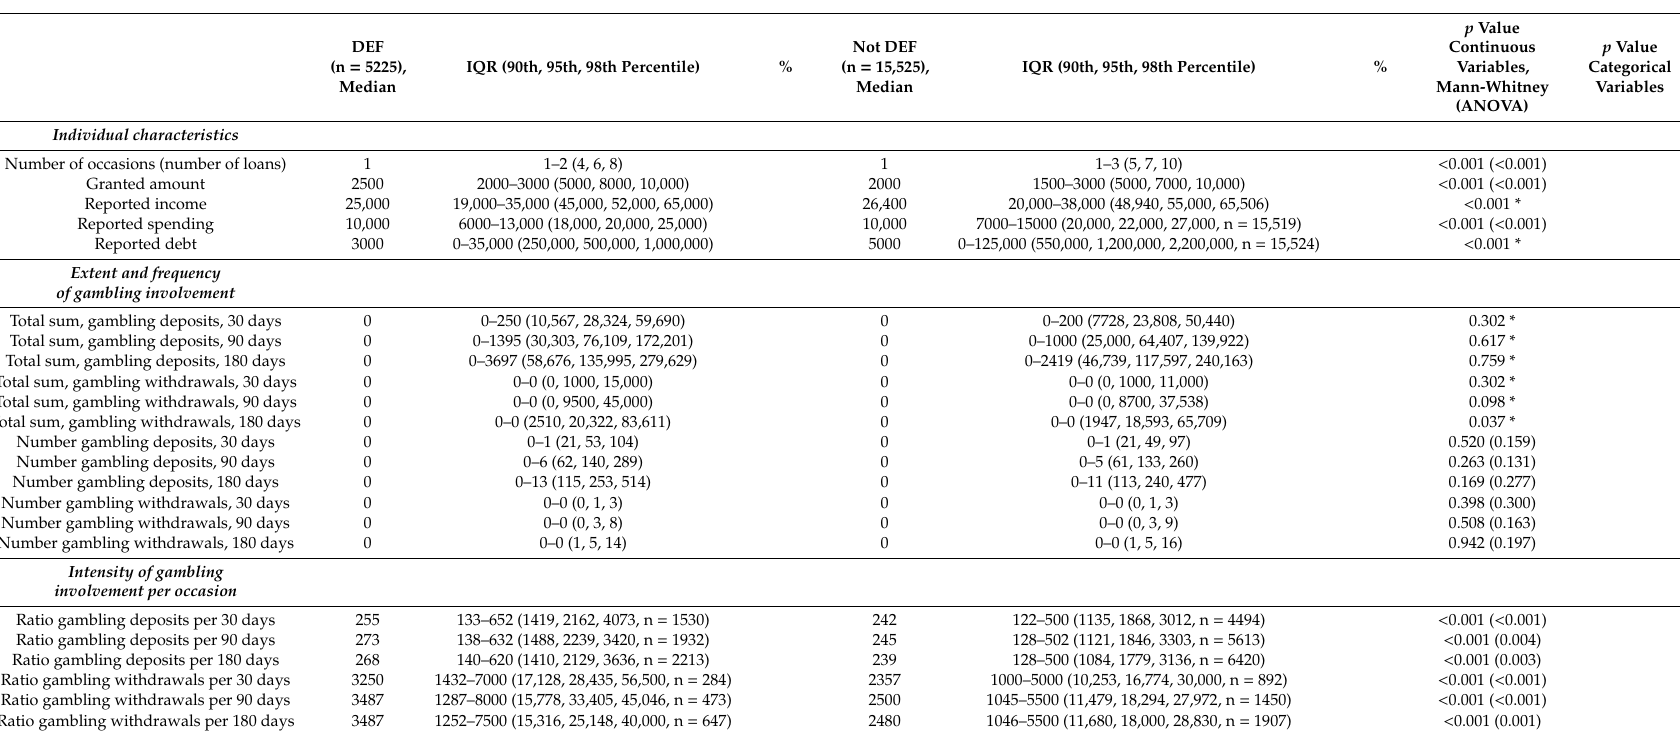
Table 2. Baseline correlates of an individual having a defaulted (DEF) loan on some occasion (primary loan or subsequent loans, N = 20,750). Comparisons made with Mann-Whitney U test (and one-way ANOVA) and chi-square tests for continuous and categorical variables, respectively. Numbers (n) in sub-analyses reported when other than the full